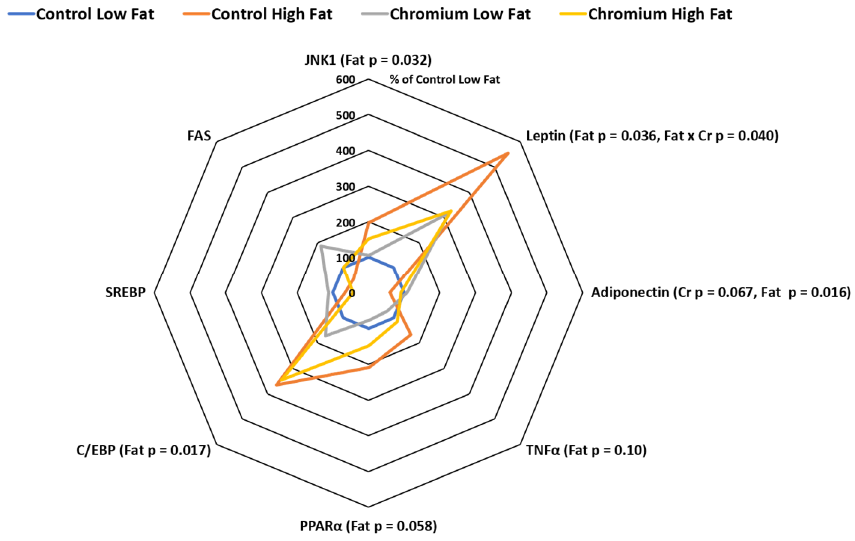
Figure 2. Leptin, adiponectin, tumor necrosis factor α (TNF α ), peroxisome proliferator-activated receptor γ (PPAR γ ), CCAAT enhancer binding protein α (C/EBP α ), sterol regulatory element-binding protein (SREBP), fatty acid synthase (FAS) and mitogen-activated protein kinase-8 (JNK1) mRNA expression in subcutaneous adipose tissue from gilts fed with nCrPic with or without a high-fat diet. All gene expression data were analysed as the threshold cycle (cT) relative to that of β-actin (∆CT) and assessed for main and interactive effects of dietary fat and nCrPic by ANOVA. A difference in ∆CT of −1.0 is associated with a doubling (200%) and +1.0 a halving (50%) of expression and for ease of presentation data are presented as % relative to expression in tissue from gilts fed the control diet without supplemental fat or nCrPic. This method of presentation prevents the presentation of the error term.